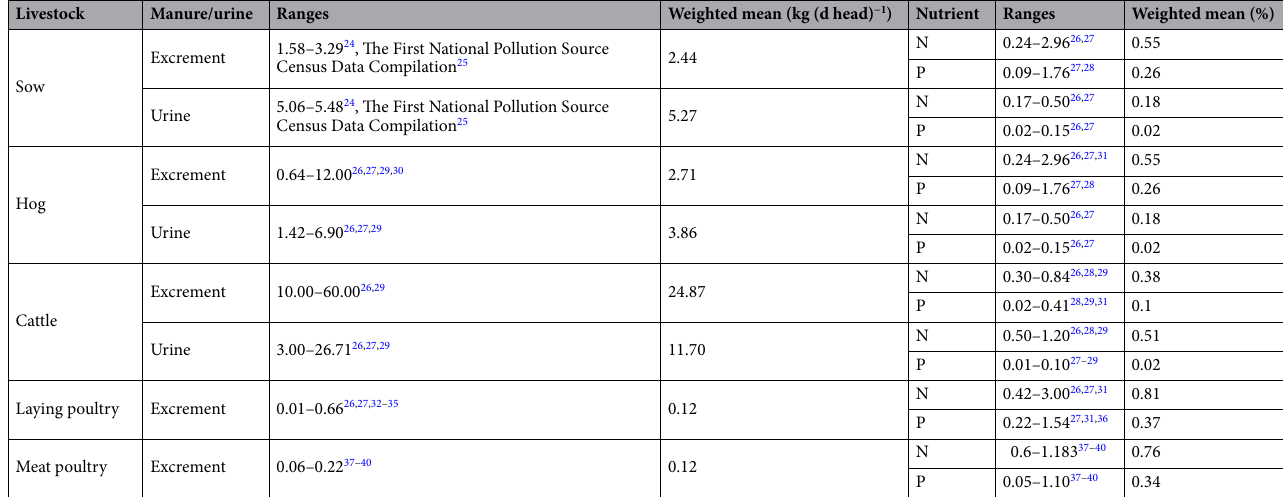
Table 1. Daily pollution coefficient of livestock excrement and urine for each livestock (fresh quality).